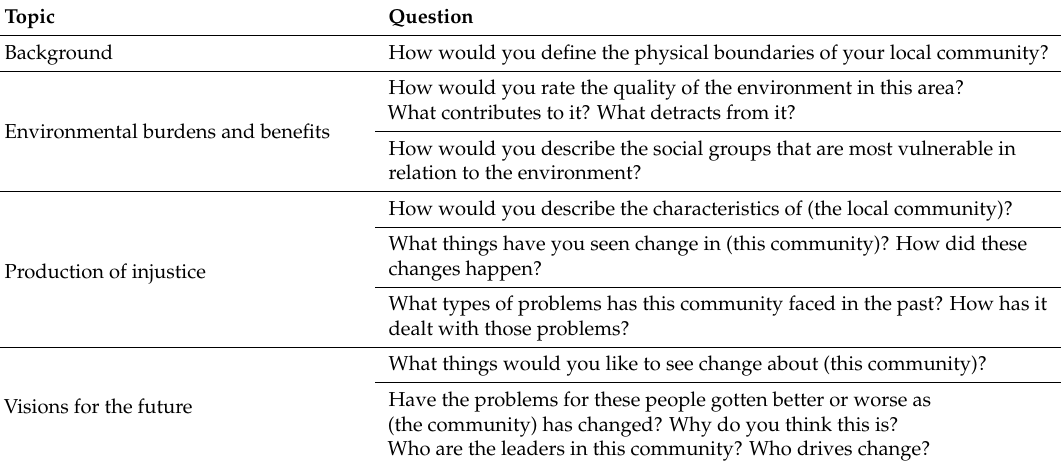
Table 1. Interview questions.